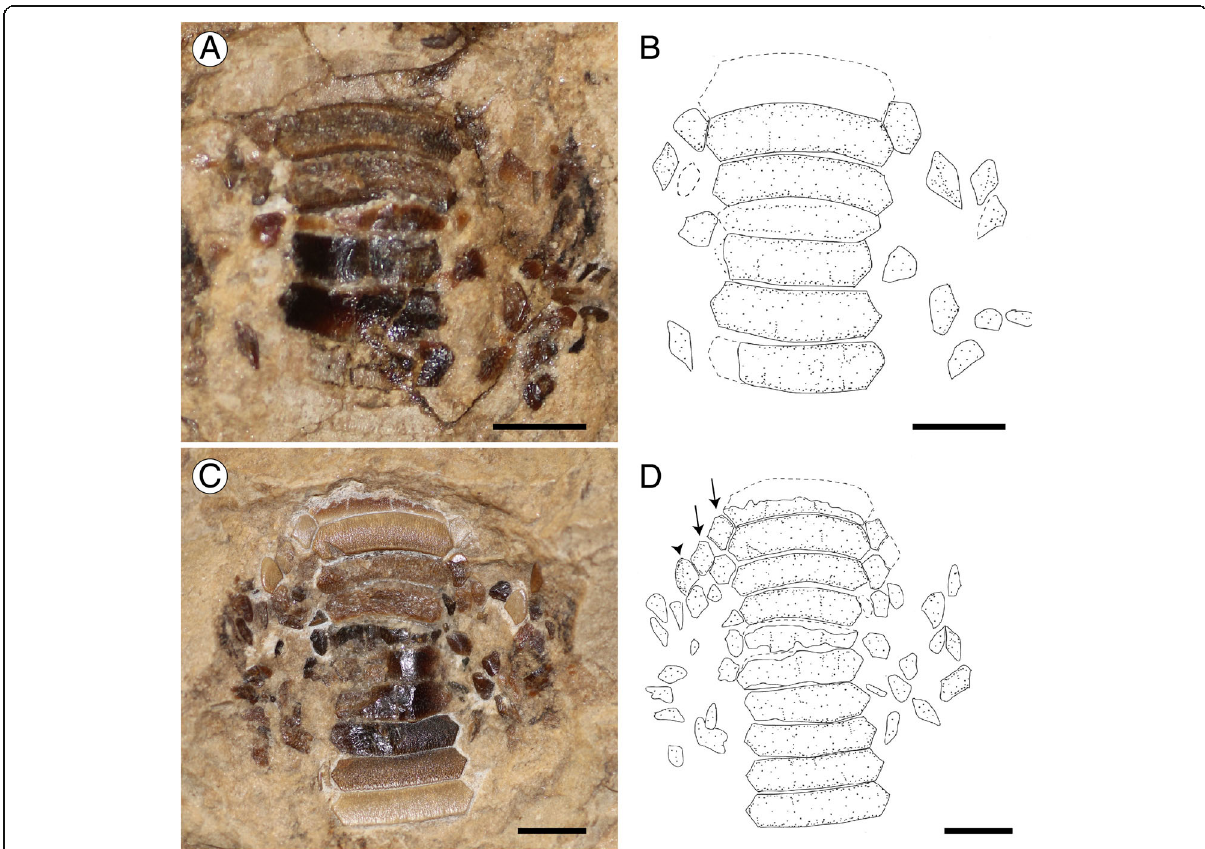
Fig. 6 Dentition of Promyliobatis gazolai from the Eocene of the Bolca Lagerstätte; specimen MCSNV VII.B.90/91. a Upper tooth plate. b Reconstruction. c Lower tooth plate. d Reconstruction. Scale bars = 5 mm. The arrows indicate the two rows of lateral teeth on lower tooth plate; arrowhead indicates the posterior row. Rostral direction